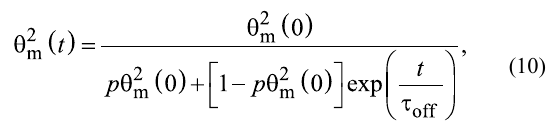
surface. In the middle of the cell ( z = 0) the deviation angle is maximum, because the molecules are out of the action range of the anchoring forces on the glass support are influenced by the ferroparticles and the magnetic field only. The maximum devia- tion angle θ m is smaller than those obtained for pure